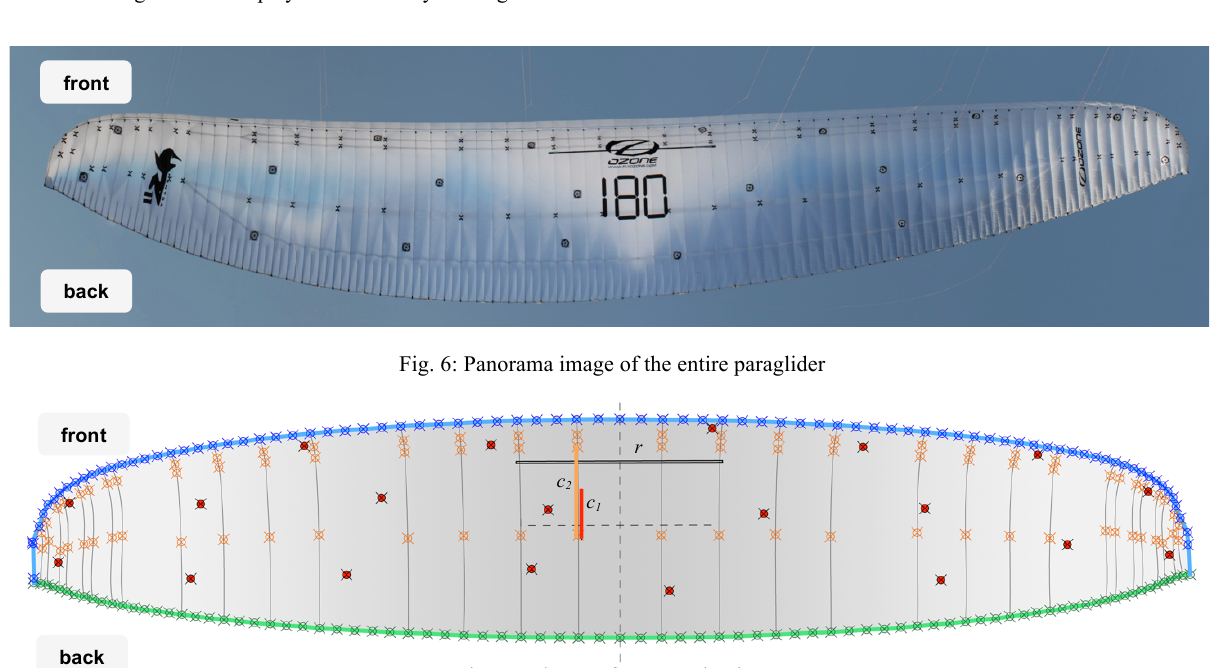
Fig. 7: Scheme of measured